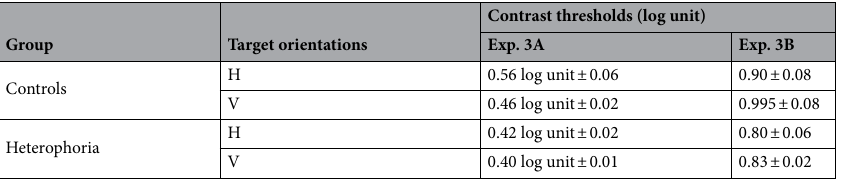
Table 5. Values of contrast detection threshold (in log units) obtained for each group for the different target orientations during different types of eye viewing (Experiment 3). H stands for horizontal, V for vertical orientation, and Exp. for